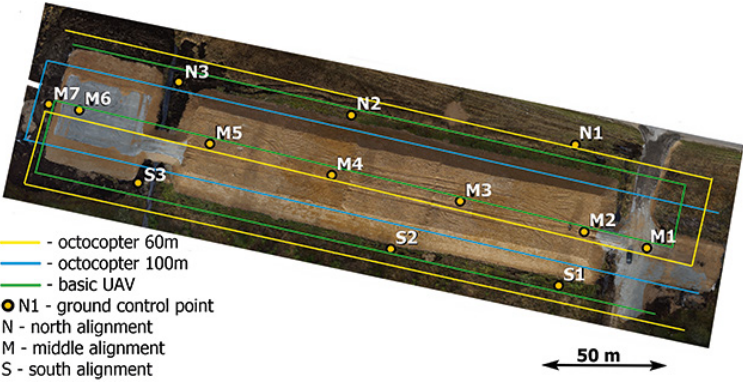
Figure 3. Flight trajectories of the unmanned aerial vehicle campaigns with the locations of the ground control